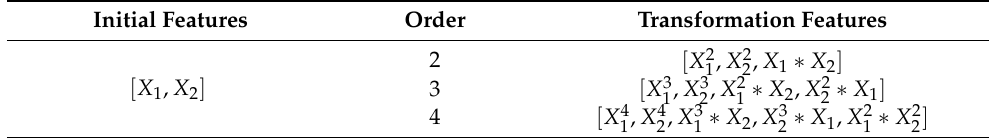
Table 8. Polynomial product feature